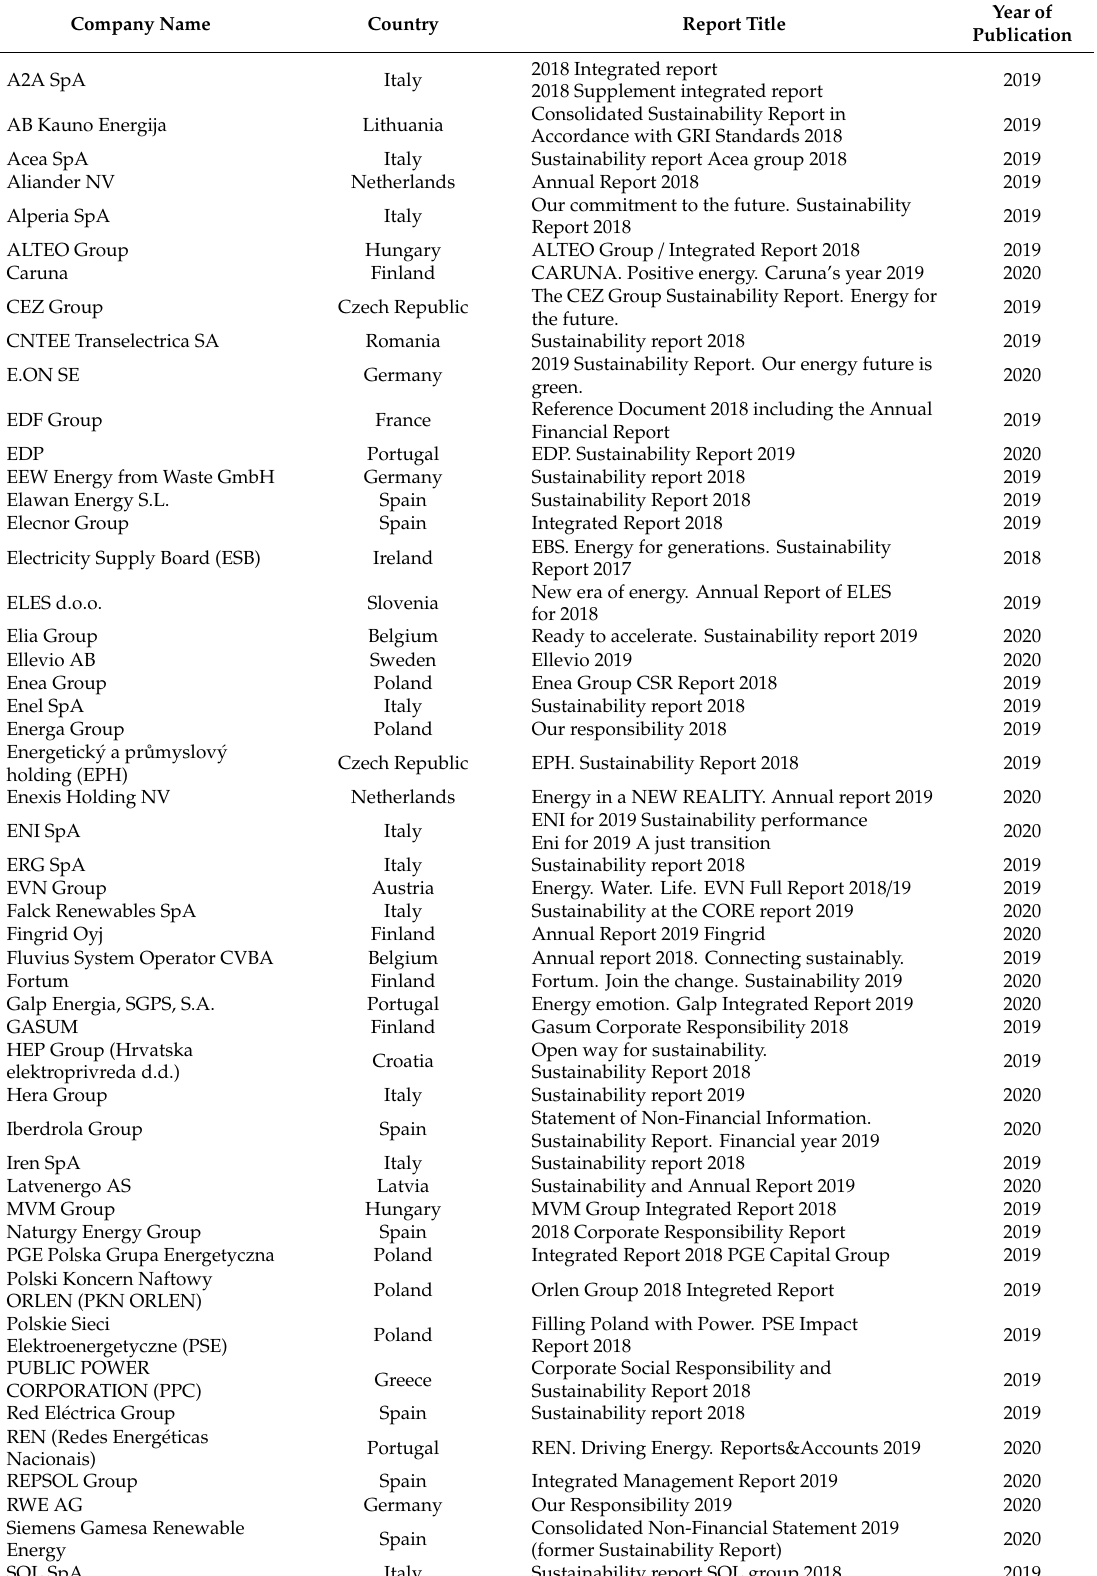
Table A3. List of sustainability reports included in the research